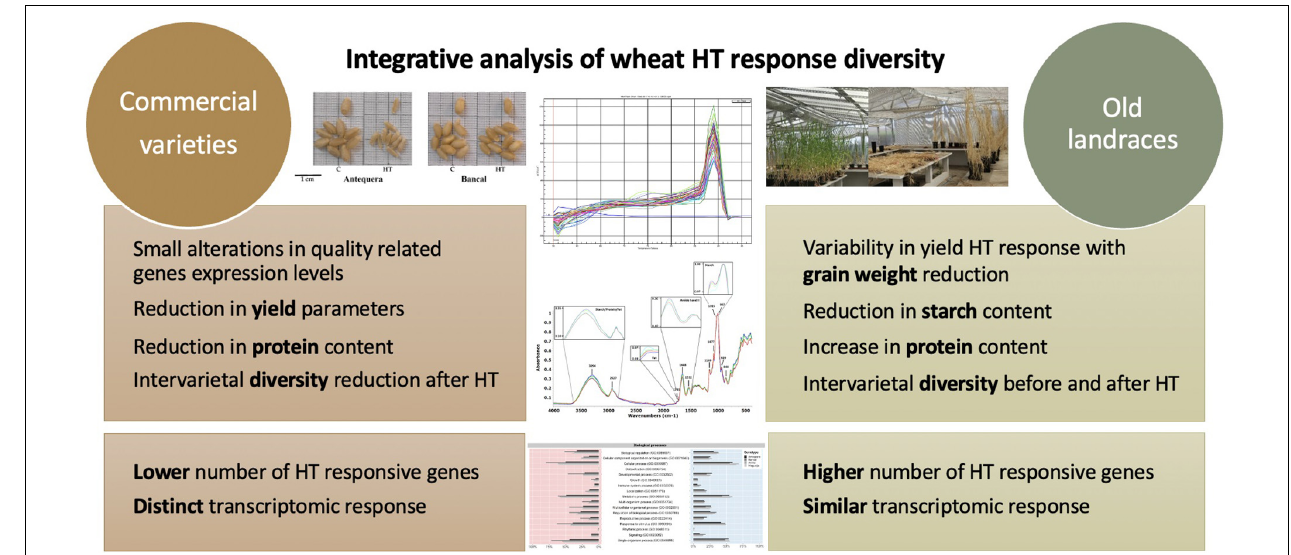
FIGURE 6 | Integrative analysis of grain yield, composition and transcriptomic analysis of the commercial varieties and the old landrace responses to heatwave at the grain-filling stage.